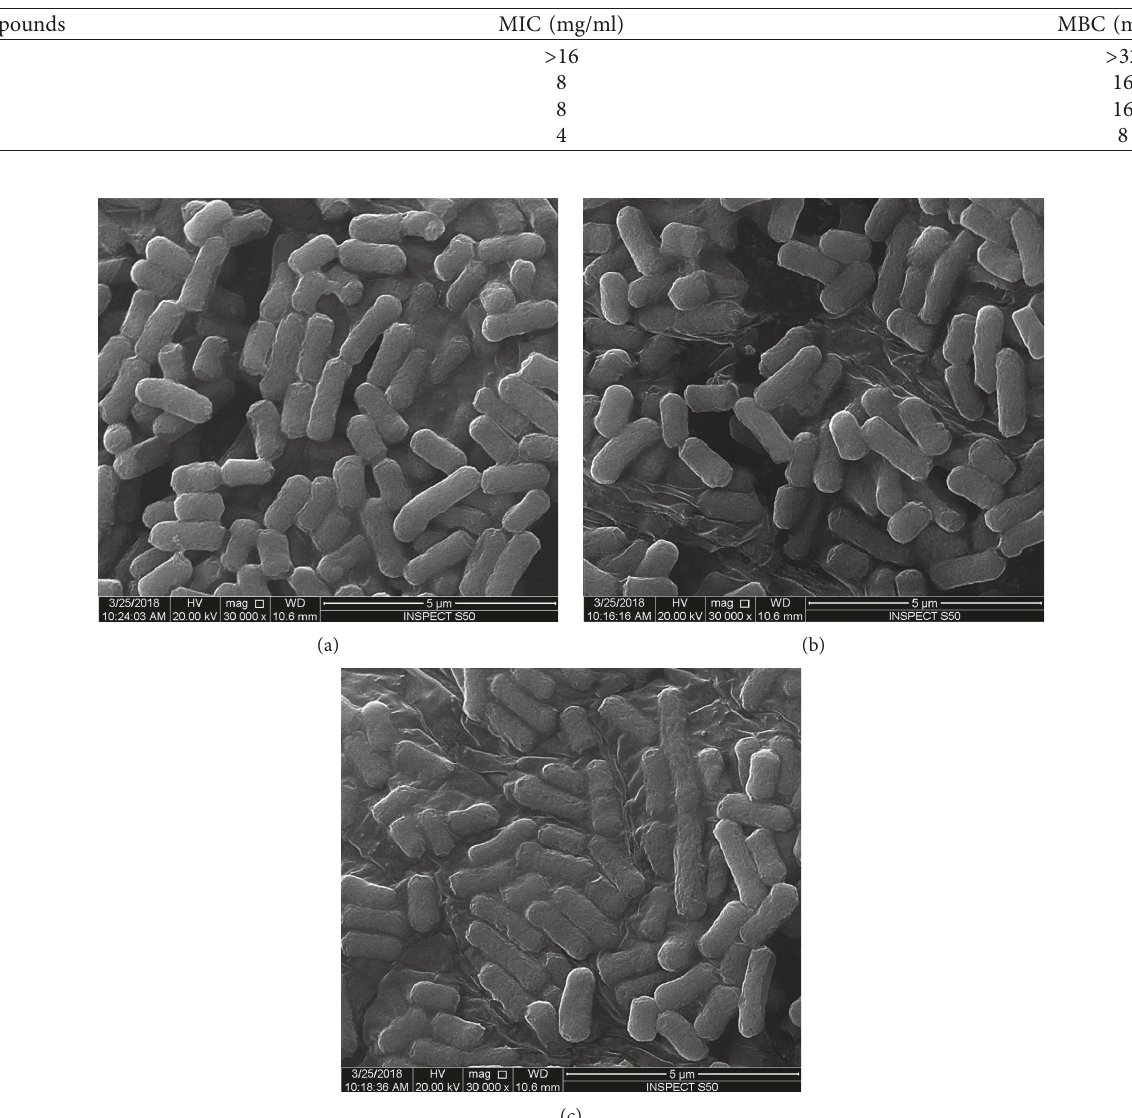
4 NiPcs 4a–d against E. coli .